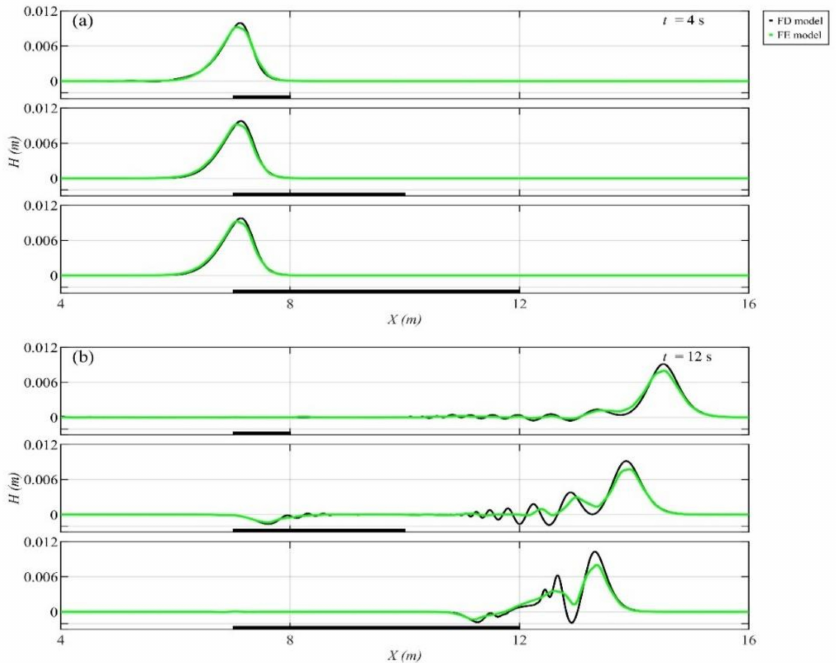
Figure 7. Comparison of the free surface at t = ( a ) 4 s and ( b ) 12 s for B/h values of 10, 30, and 50 (black lines: FD model results; green lines: FE model results; the black thick line indicates the position of the submerged